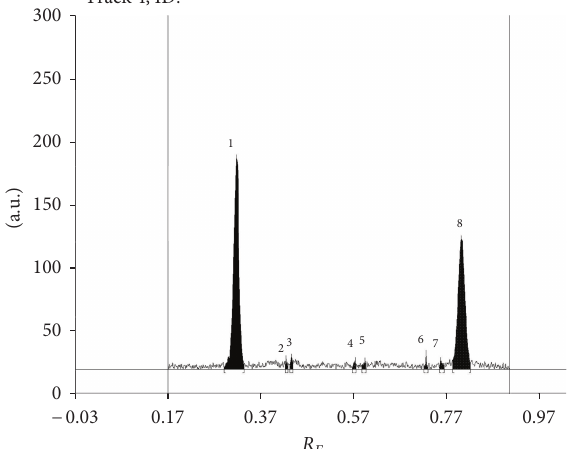
3.3. Stability. Stability of the rutin and rosmarinic acid